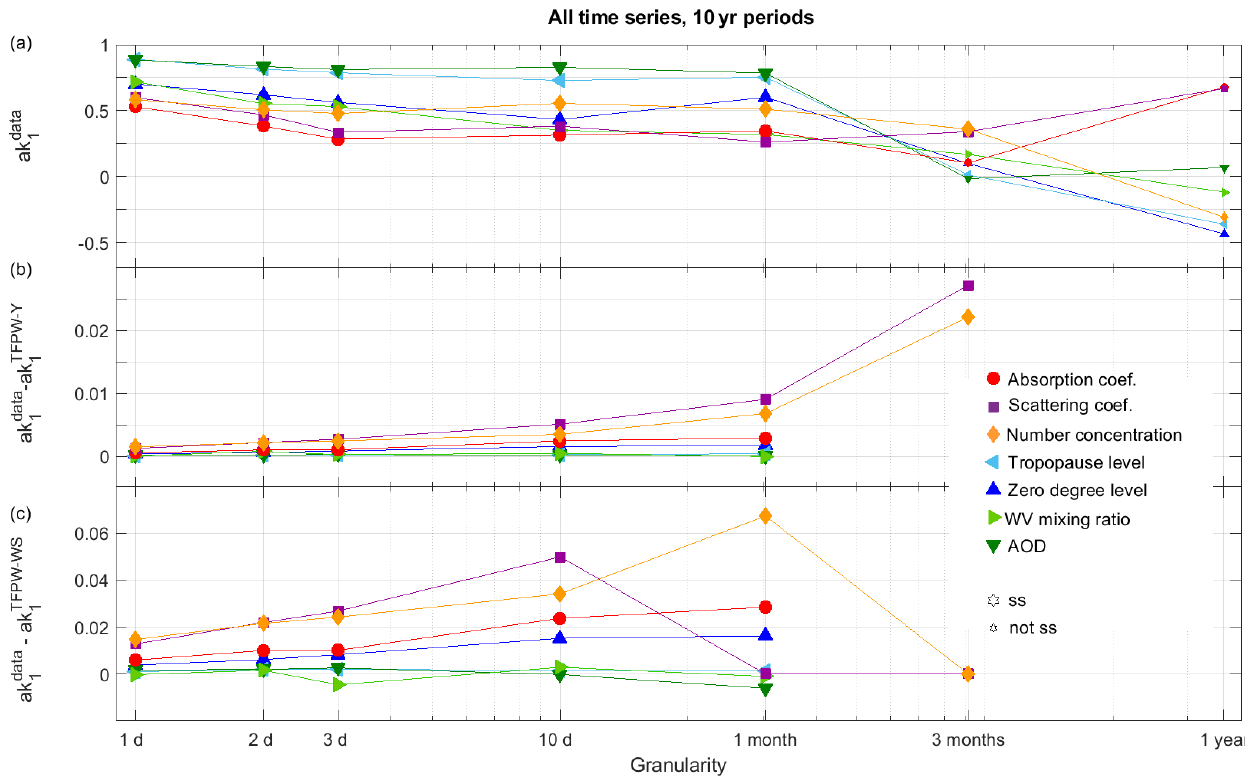
Figure 6. (a) Lag-1 autocorrelation (ak data ) of the original data as a function of the time granularity for the 10-year time series of all 1 parameters; bigger symbols correspond to ss ak data , (b) ak 1 difference between the original data and the TFPW-Y data, and (c) ak 1 difference 1 between the original data and the TFPW-WS data. For (b, c) only ss cases are plotted because prewhitening methods are not applied when ak 1 is not